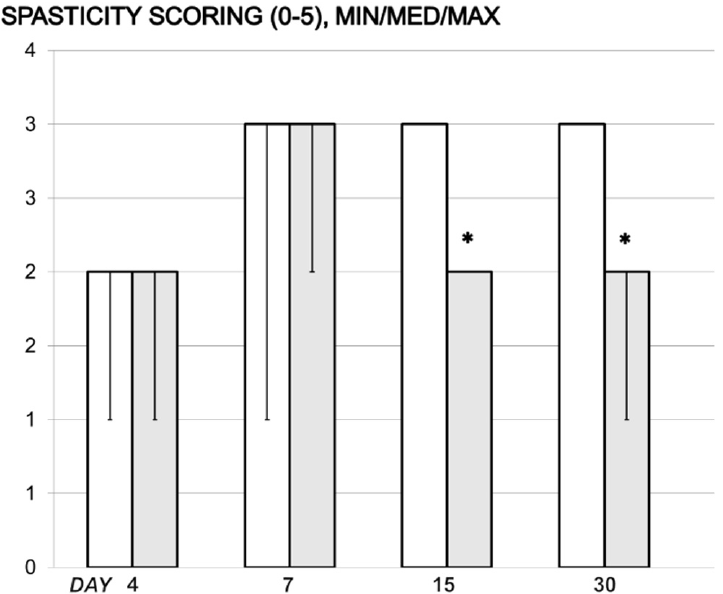
Figure 3. In rats with a spinal cord injury, debilitated (control rats drinking water 12 mL/day/rat, white bars) and rescued tail spasticity (BPC 157 (10 μ g/kg) in drinking water from day 4 post-injury, grey bars) presented by the tail spasticity score, Min/Med/Max. * p < 0.05, at least, vs. control.